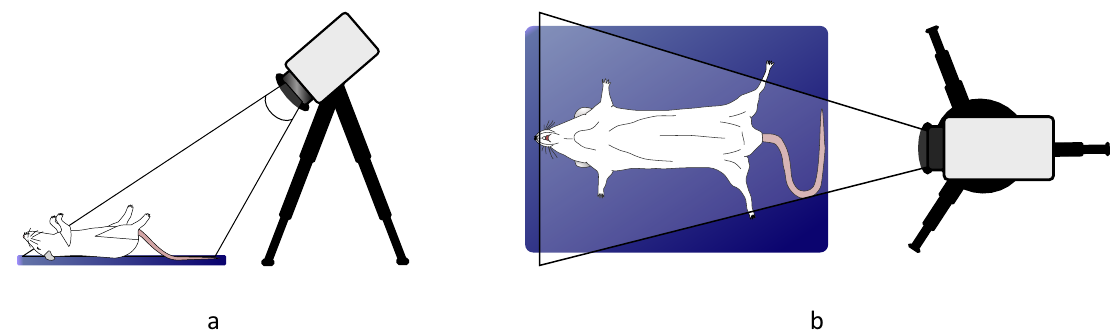
Figure 2. Illustration of the measurement setup for RR assessment: ( a ) side view and ( b ) top view.